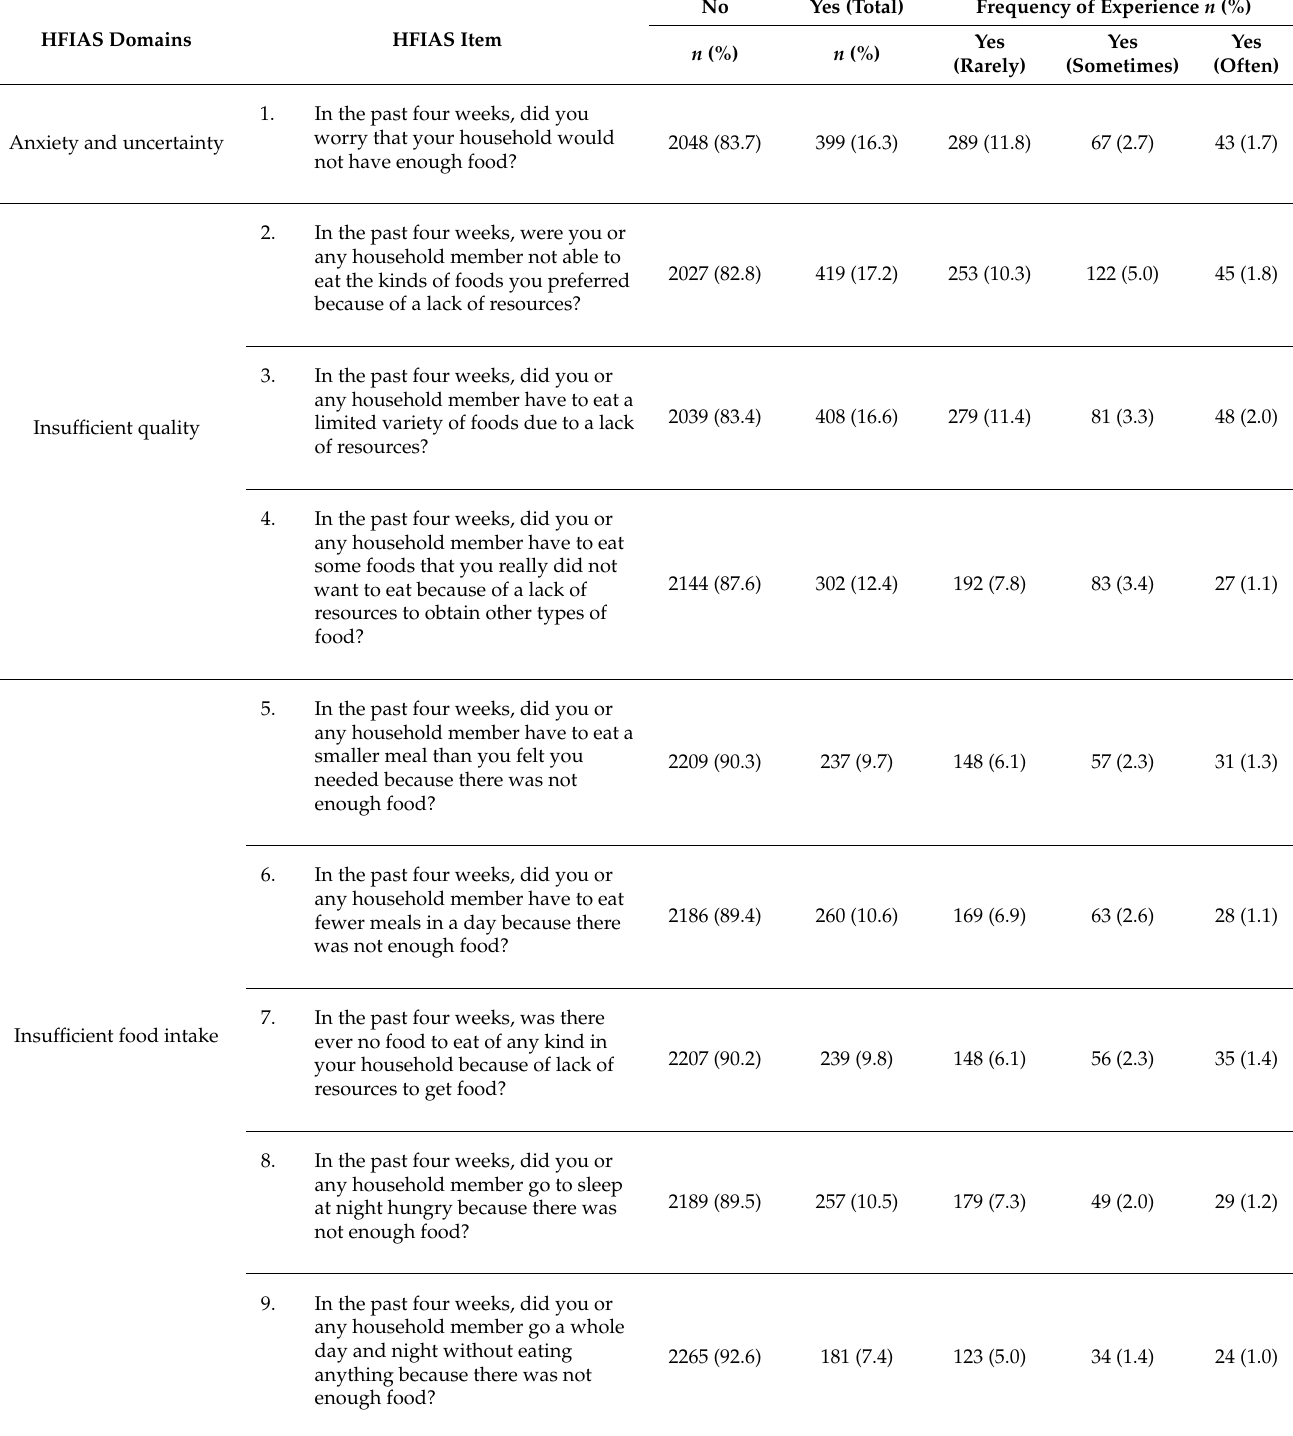
Table 3. The weighted prevalence and frequency of each item in the Household Food Insecurity Access Scale (HFIAS).